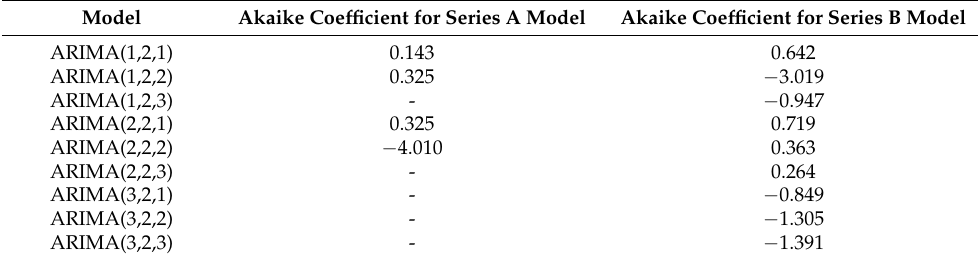
Table 2. The Akaike coefficient of tested ARIMA models, based on A. baerii time series data.